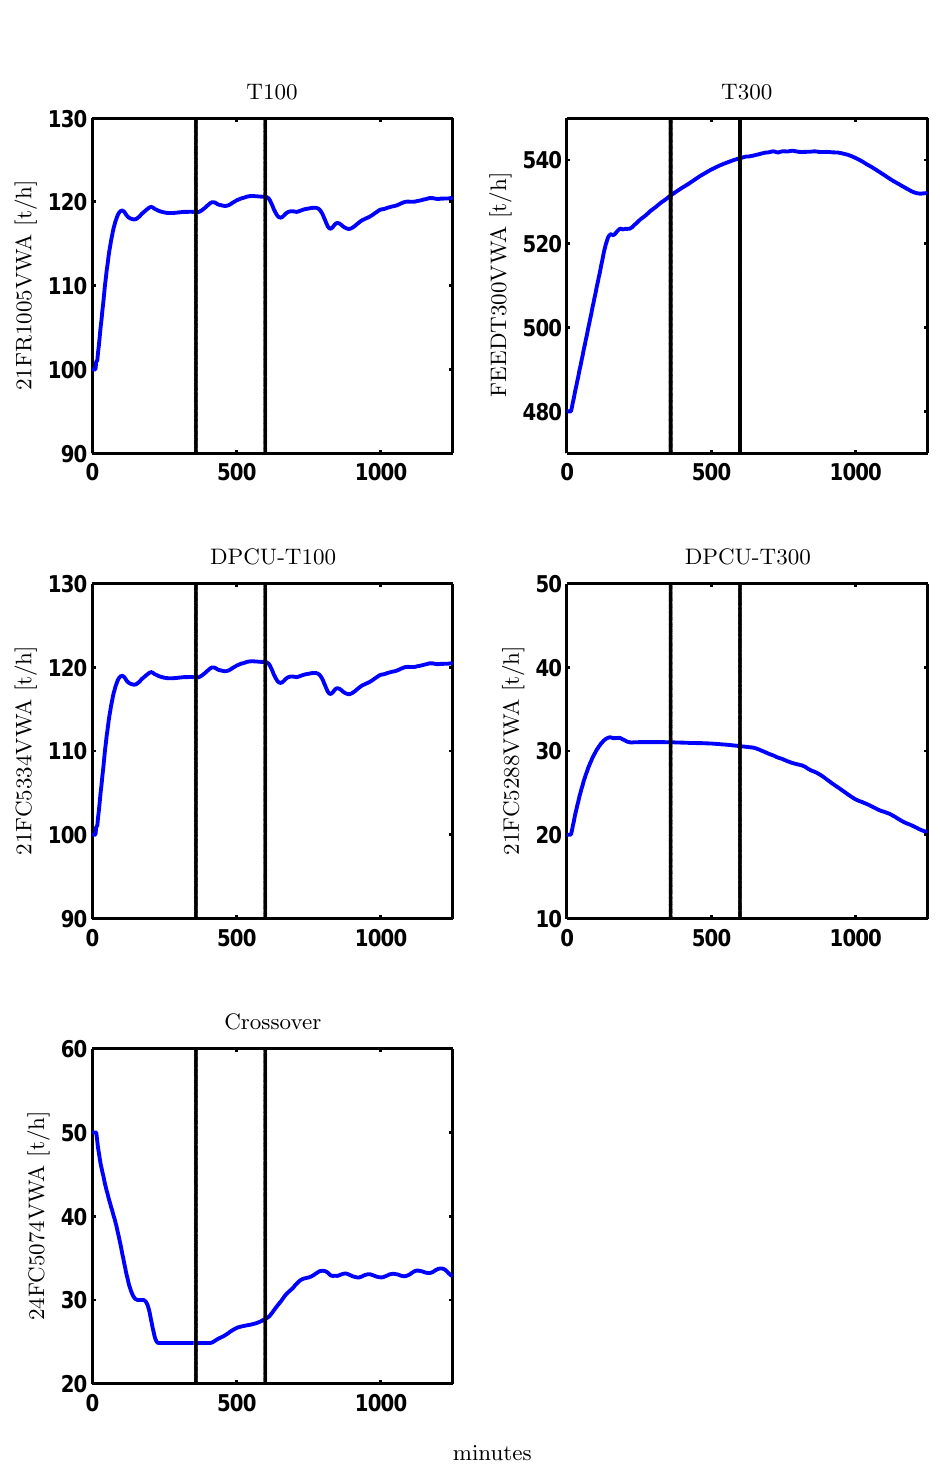
Figure 5: MVs in the coordinator MPC. Vertical lines indicate new